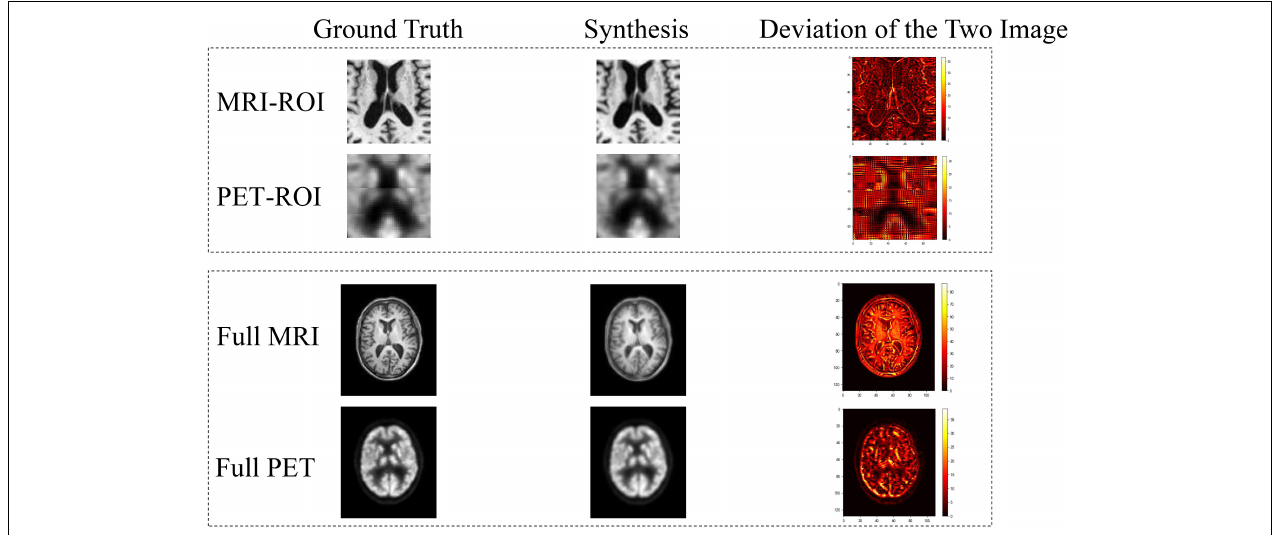
FIGURE 7 | Deviation between real image and synthetic images. In the deviation image, the yellower the color, the greater the error, and the red and black areas represent smaller deviation. TABLE 2 | Comparison with others.